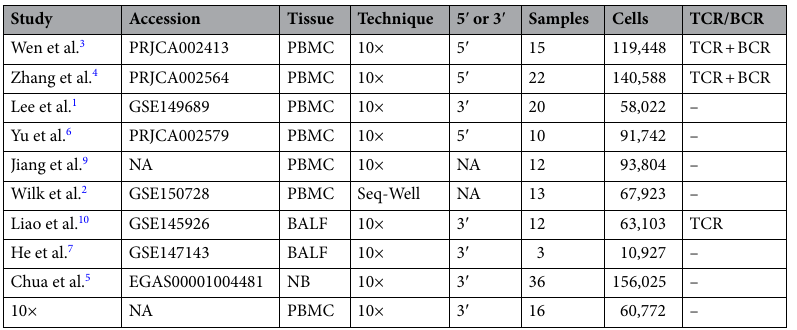
Table 1. The scRNA-seq studies of SARS-CoV-2 infected patients samples included in this meta-analysis.